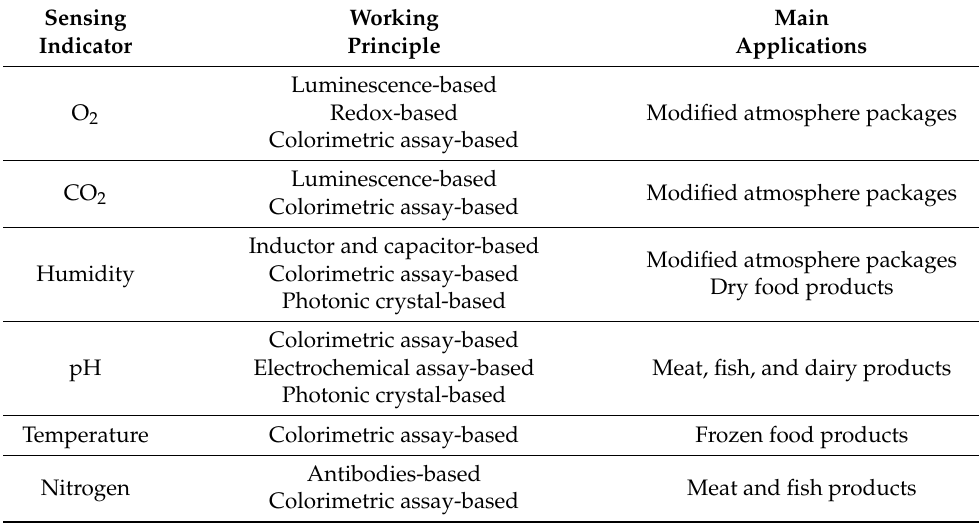
Table 1. Summary of the main food quality and safety indicators and their main applications in food